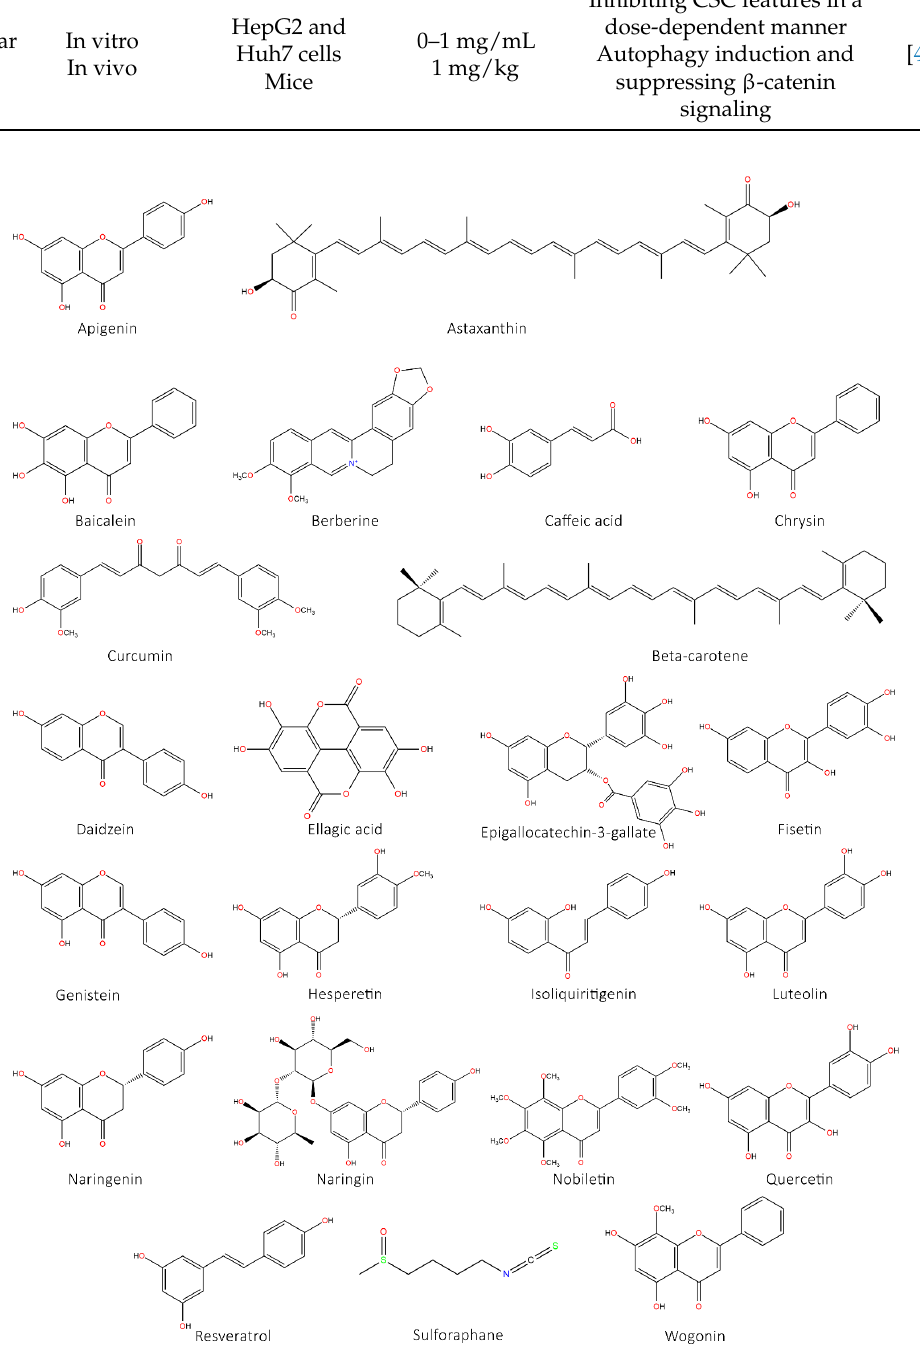
Figure 8. The chemical structures of selected phytochemicals discussed in the review.